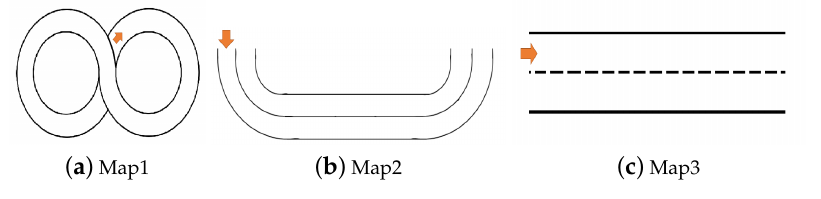
Figure 17. Scenario